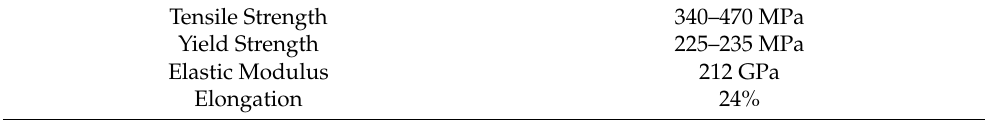
Table 1. Basic mechanical properties of steel S235J0 at a temperature of 20 ◦ C